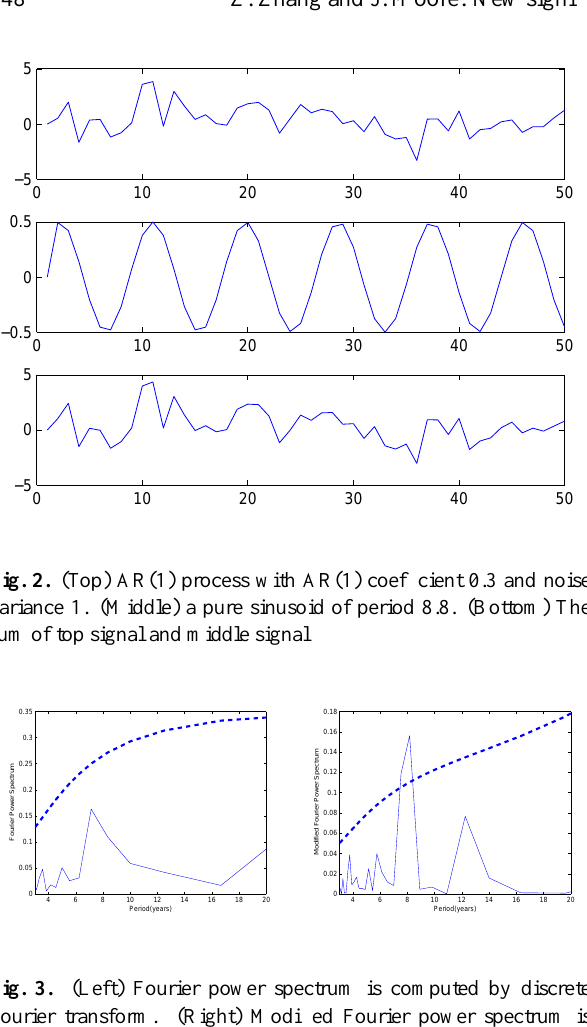
Figure 3: (Left) Fourier power spectrum is computed by discrete Fourier transform. (Right) Modified Fourier power spectrum is computed by our method. The dashed line is 99% confidence red noise spectrum .